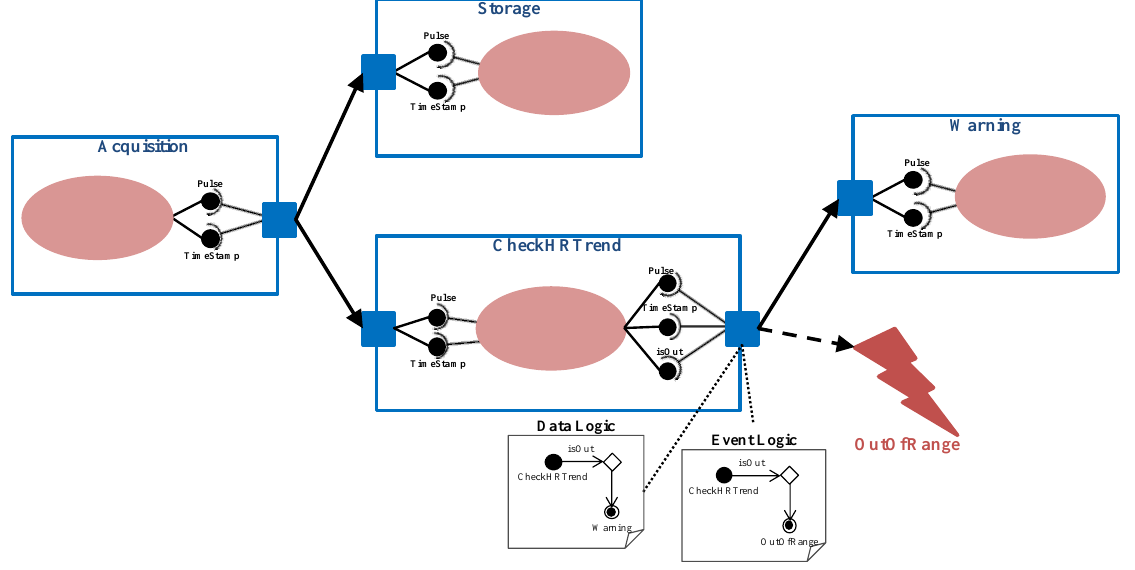
Figure 3. Definition of the application for heart rate monitoring.